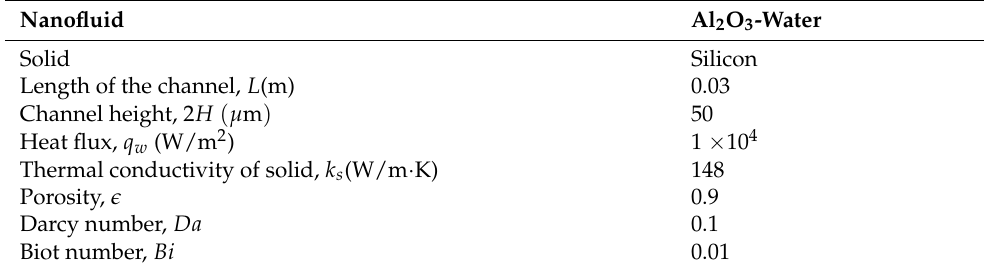
Figure 6. Schematic diagram of the composite microchannel. Table 3. Specifications of a microchannel [42].